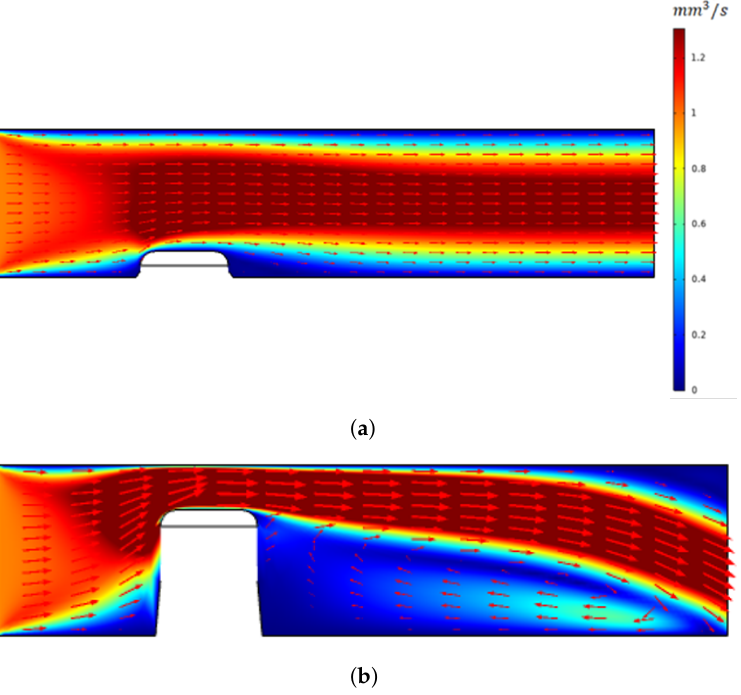
Figure 12. CFD analysis insight of pulsation flow. ( a ) Laminar flow with valve turned ‘on’. ( b ) Turbulent flow with valve turned